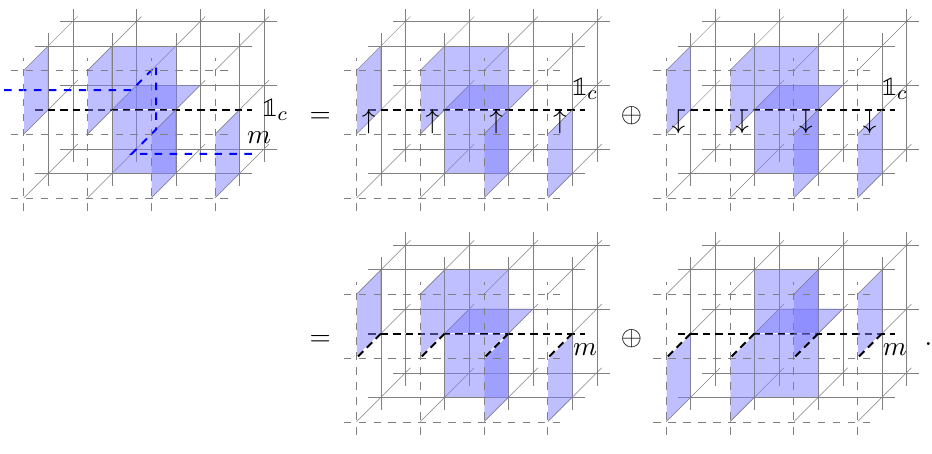
Figure 28. The half-braiding of the 1 c -string with the m -string on the rough boundary.